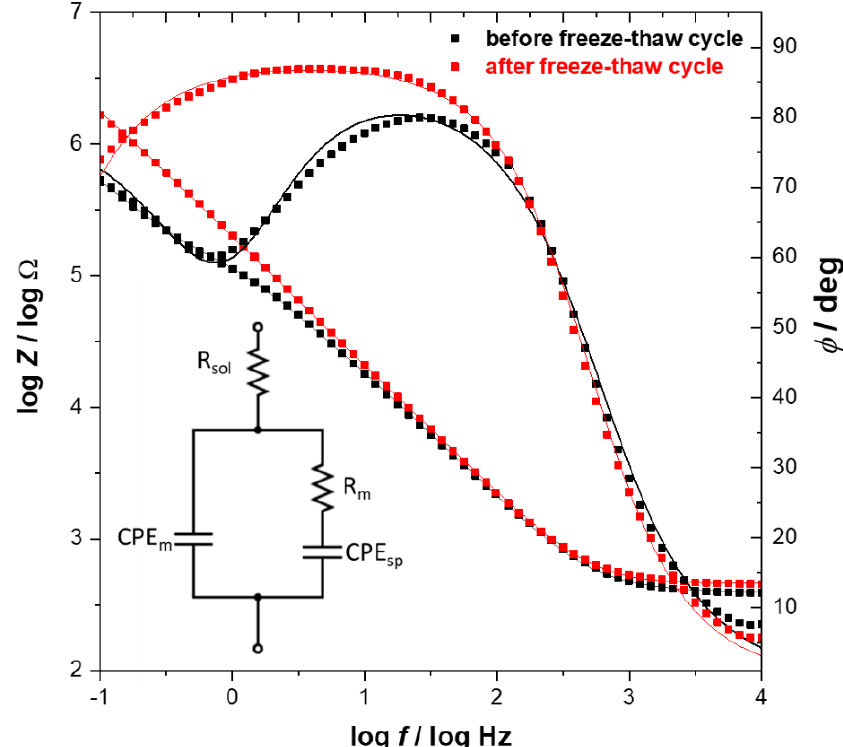
Figure 5. Bode plot obtained for the thioglucose-modified Au(111) electrode with lipid film before (black) and after (red) one freeze-thaw cycle. Solid lines represent the fit based on the equivalent circuit shown as an inset, where R sol is the resistance of the electrolyte, R m and CPE m are the resistance and constant phase element of the lipid membrane, and CPE sp represents the constant phase element of the spacer region between the gold surface and lipid film.